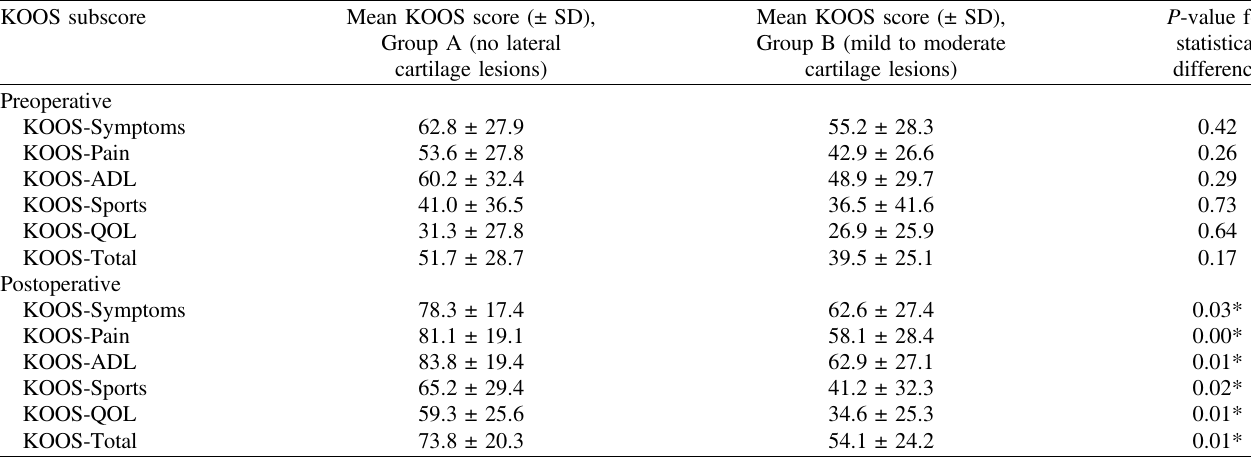
Statistically signi fi cant values are marked by an asterisk. SD: standard